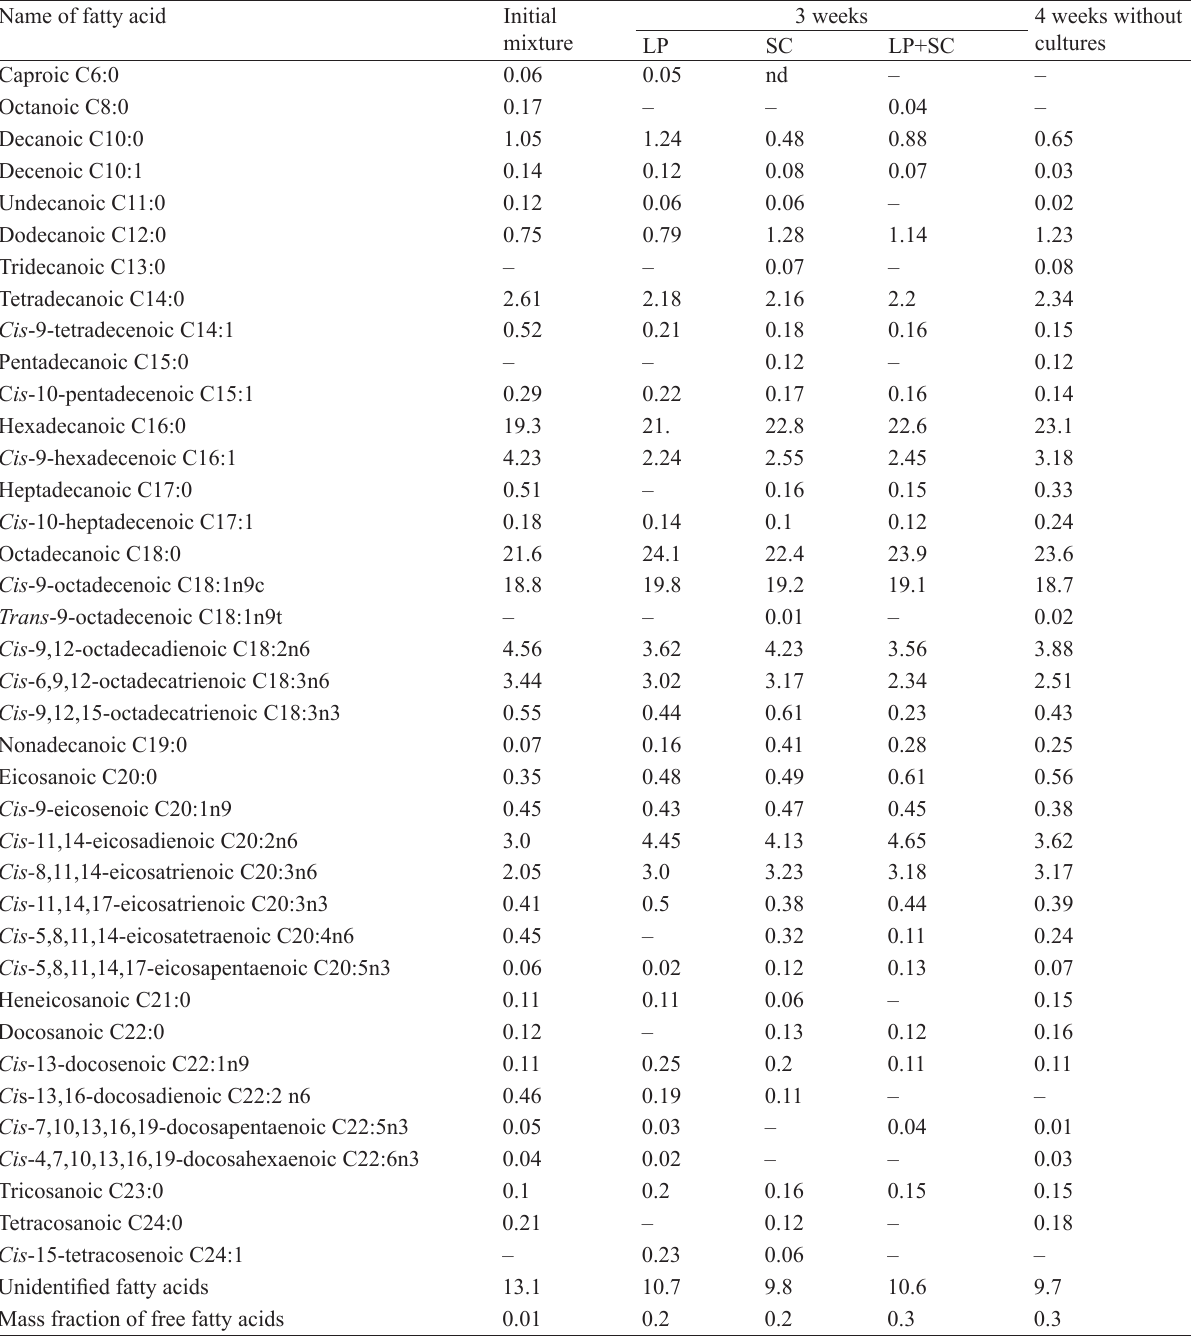
Table 3 Changes in the fatty acid composition of the animal-based food system treated with Lactobacillus plantarum , Staphylococcus carnosus and their mixture, % of total Name of fatty acid